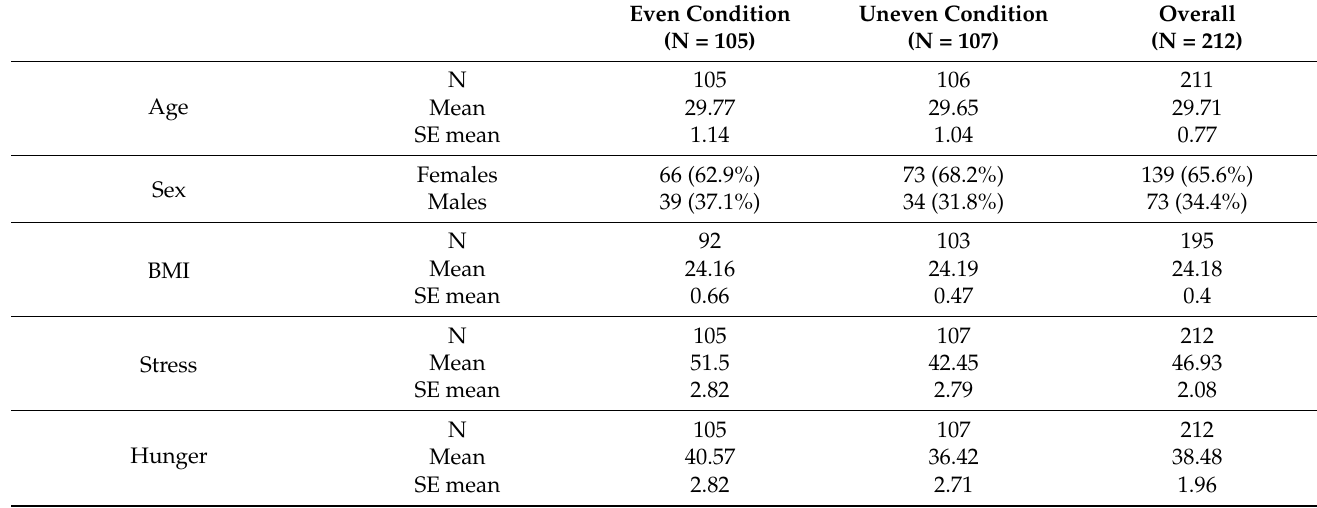
Table 1. Demographic information of the sample and across the two independent conditions. Due to data catchment errors and missing data points, only complete descriptive datasets are reported here. The corresponding N is reported for each demographic